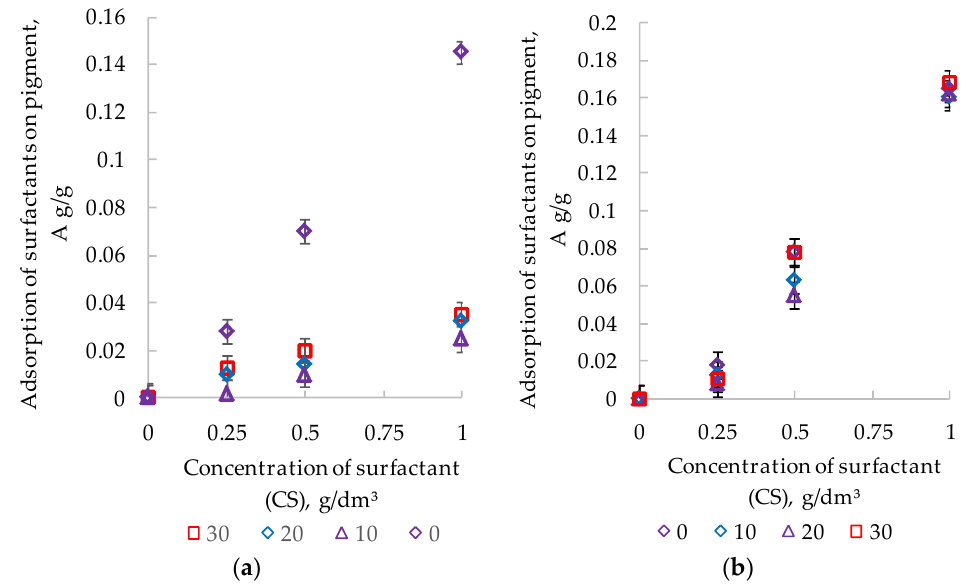
Figure 3. Isotherms (T = 298 K) of adsorption in the presence of PC ( a ) and NaPA ( b ) with the content of the film-forming agent in the system: 1 — 0%, 2 — 10%, 3 — 20%, 4 — 30%.